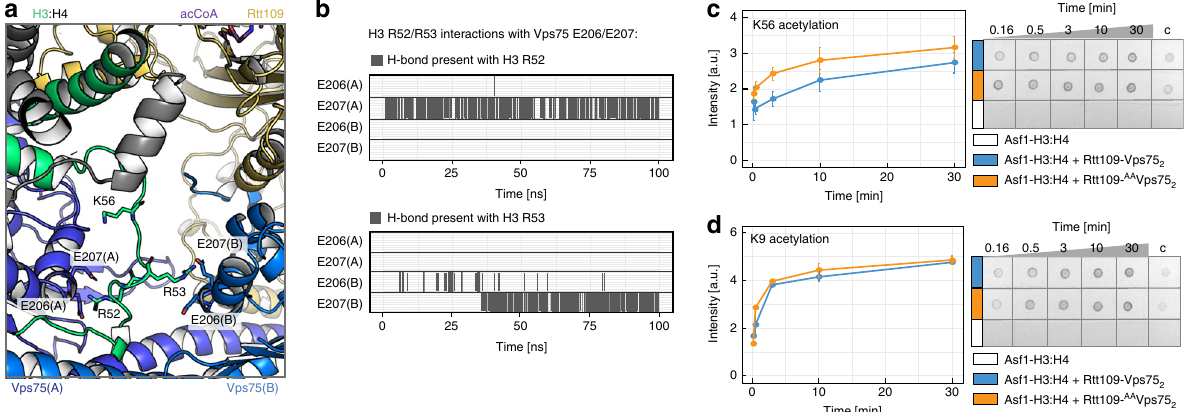
Fig. 3 The Vps75 acidic patch keeps K56 away from the Rtt109 catalytic pocket. a Final snapshot of the 100-ns MD trajectory of Asf1 – H3 35 – 135 : H4 – Rtt109 – Vps75 2 1 – 225 , starting from the structure of Fig. 1. The stretch H3 35 – 59 was initially built in an extended conformation (Supplementary Fig. 8). During the MD run, stable H-bonds were formed between H3-R52 and Vps75(A)-E207 and between H3-R53 and Vps75(B)-E207; these contacts are incompatible with H3-K56 binding in the Rtt109 catalytic center. b Analysis of the H-bonds during the MD run. c , d Time-courses (left) of K56- and K9- acetylation quanti fi ed by dot-blot assays (right). The assays and data-analysis were done as described in the legend to Fig. 2. Source data are provided as a Source Data fi